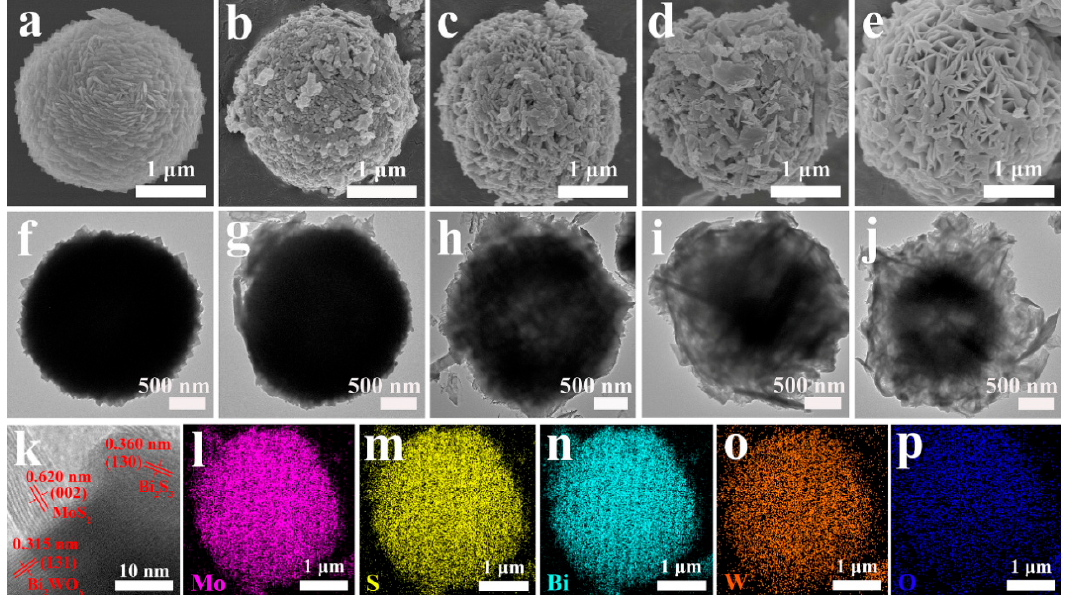
Figure 2. Scanning electron microscope (SEM) and transmission electron microscope (TEM) images of ( a , f ) bare Bi 2 WO 6 , ( b , g ) BBM-1, ( c , h ) BBM-2, ( d , i ) BBM-3, and ( e , j ) BBM-4. High-resolution TEM (HRTEM) image ( k ), and energy-dispersive spectra (EDS) mapping images ( l – p ) of BBM-3.